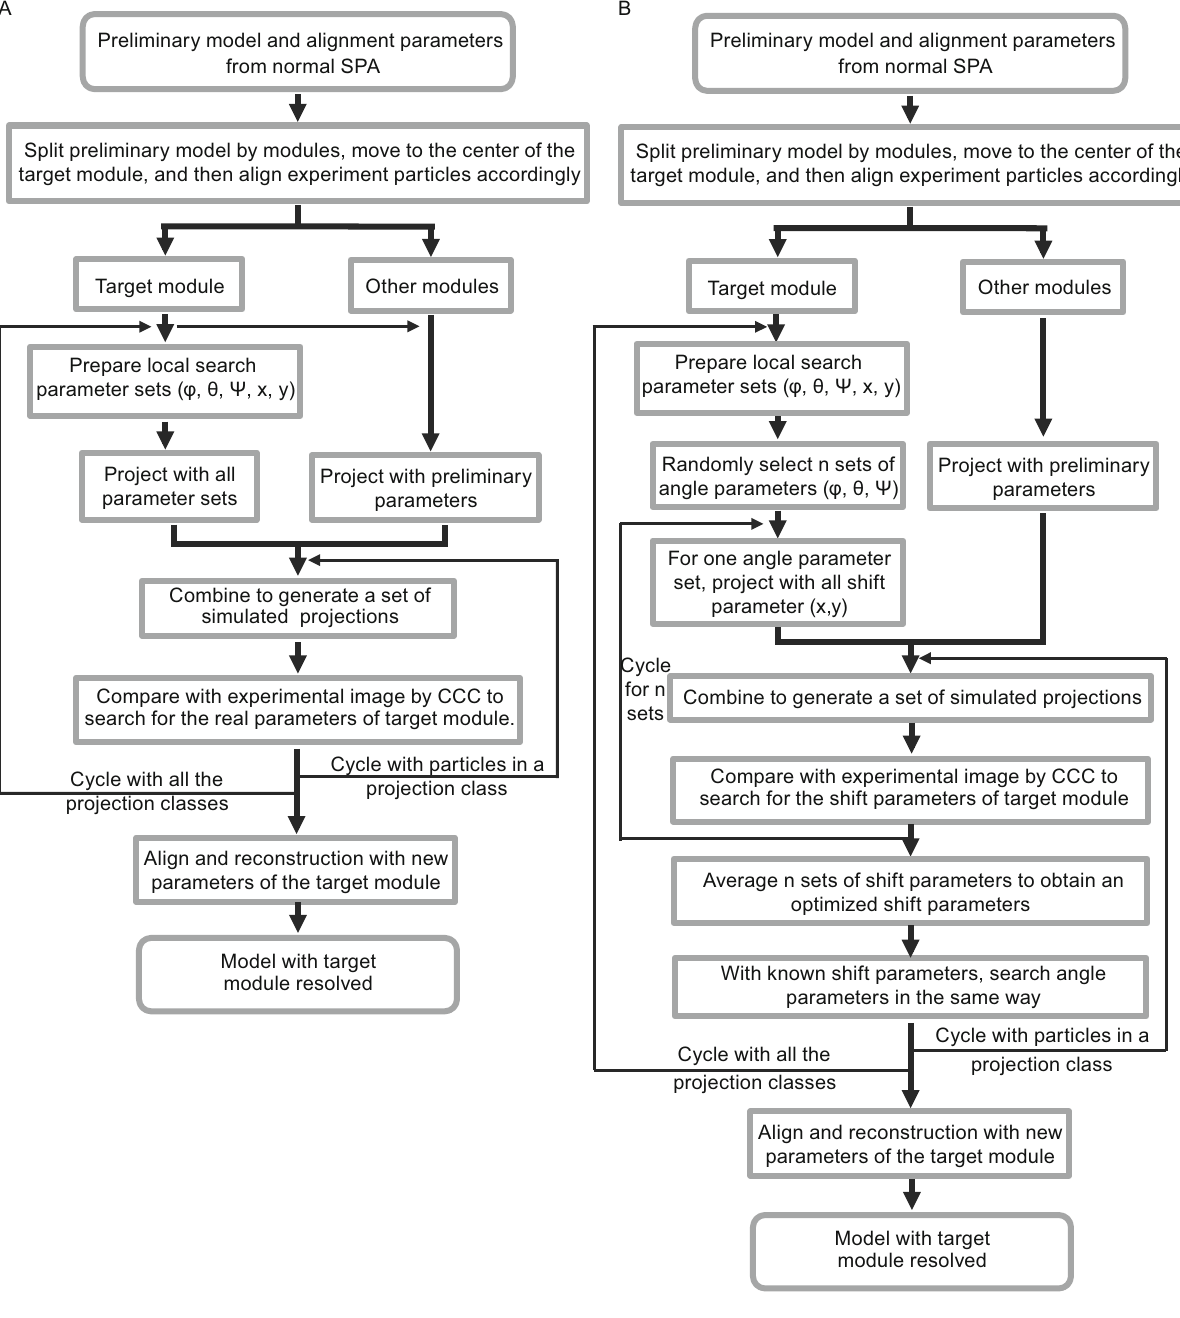
Figure 3. Diagram showing the local optimization procedures with two different strategies. (A) The procedure for searching the shift (x, y) and angle parameters ( φ , θ , ψ ) simultaneously and exhaustively. (B) The procedure for searching the shift (x, y) and angle parameters ( φ , θ , ψ )